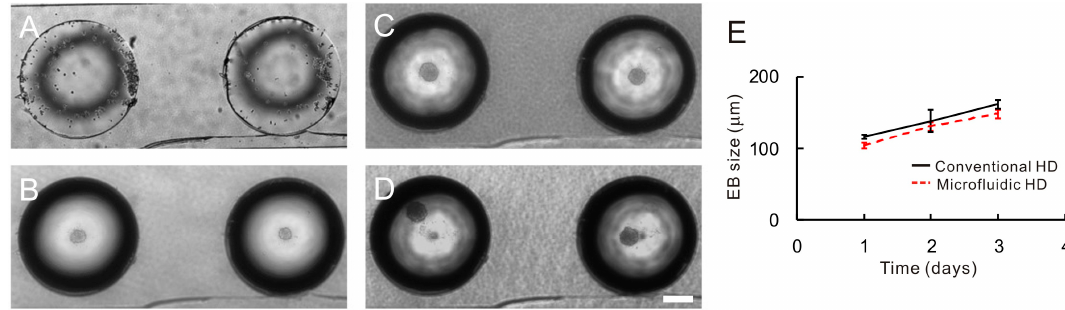
Figure 5. EB growth observation for 3 days. ( A – D ) Images of EBs taken at day 0 ( A ); day 1 ( B ); day 2 ( C ) and day 3 ( D ) after cell seeding; ( E ) the growth curves of the EBs cultured in the μ HD chip and conventional hanging drop system. The scale bar is 200 μ m.